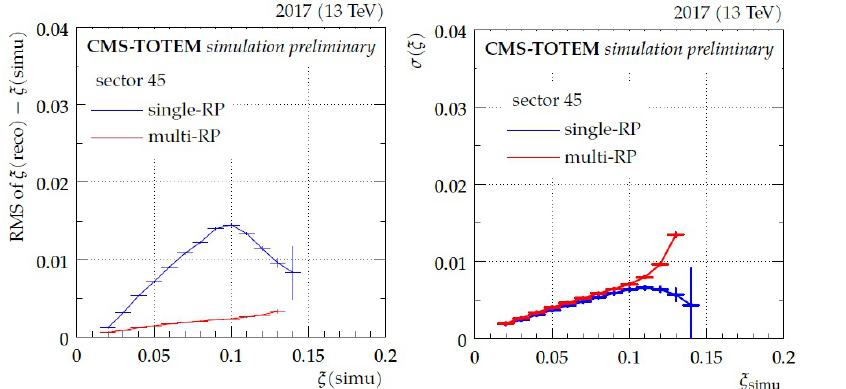
Figure 2: Comparison between single and multi-RP reconstruction using simulated data: resolution (left) and systematic uncertainties